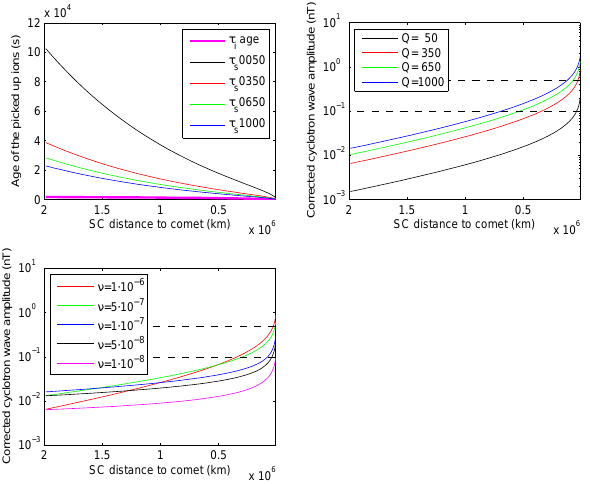
Fig. 3. Top left: The age (cid:28) i of the implanted ions and the scatter time (cid:28) s for different gas production rates. Fig. 3. Top left: the age τ i of the implanted ions and the scatter time Top right: The corrected wave amplitude for different source rates. Bottom left: The scatter-time-corrected τ s for different gas production rates. Top right: the corrected wave cyclotron wave amplitude for different values of the ionization rate (cid:23) and a constant outgassing rate of Q = amplitude for different source rates. Bottom left: the scatter-time- 350 (cid:1) 10 23 s (cid:0) 1 . Thelowerhorizontaldashedlinemarks0.1nTsolarwindnoiselevelandtheupperdashedline corrected cyclotron wave amplitude for different values of the ion- showsthe0.5nTamplitudelevel. ization rate ν and a constant outgassing rate of Q = 350 × 10 23 s − 1 . The lower horizontal dashed line marks 0.1nT solar wind noise level, and the upper dashed line shows the 0.5nT amplitude